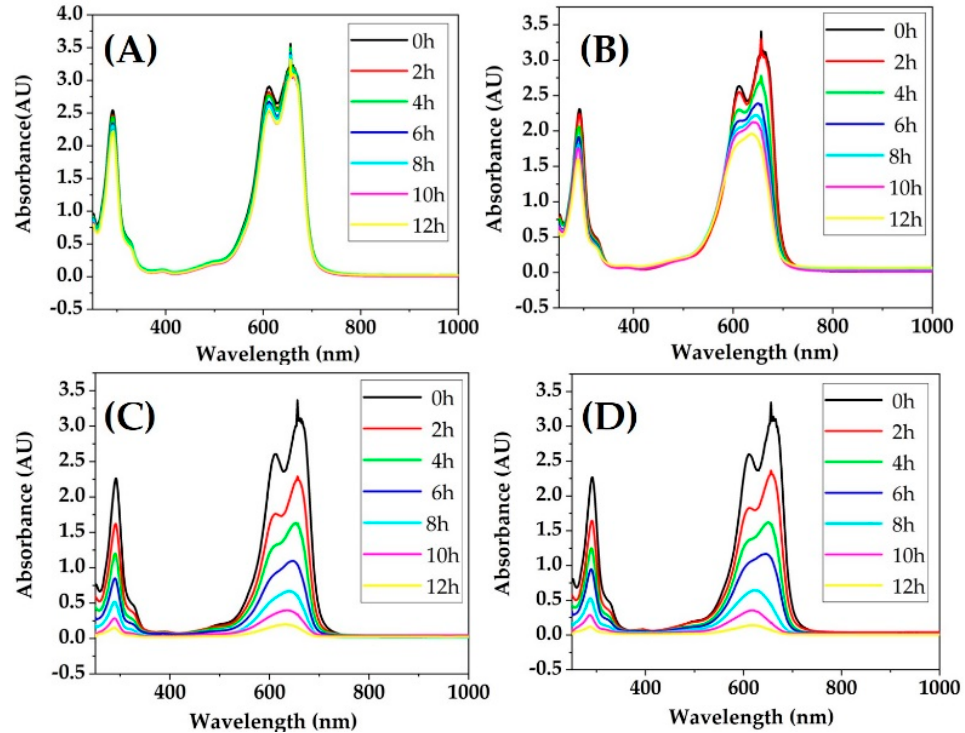
Figure 11. Ultraviolet–visible spectroscopy (UV–Vis) spectral change of photocatalytic decomposition of methylene blue over time using diameter-controlled nanofibers: ( A ) UV without nanofibers, ( B ) UV with 0.5 g TiO 2 nanofiber added, ( C ) UV with 0.5 g TiO 2 /ZnO-1 nanofiber added, ( D ) UV with 0.5 g TiO 2 /ZnO-2 nanofiber added.